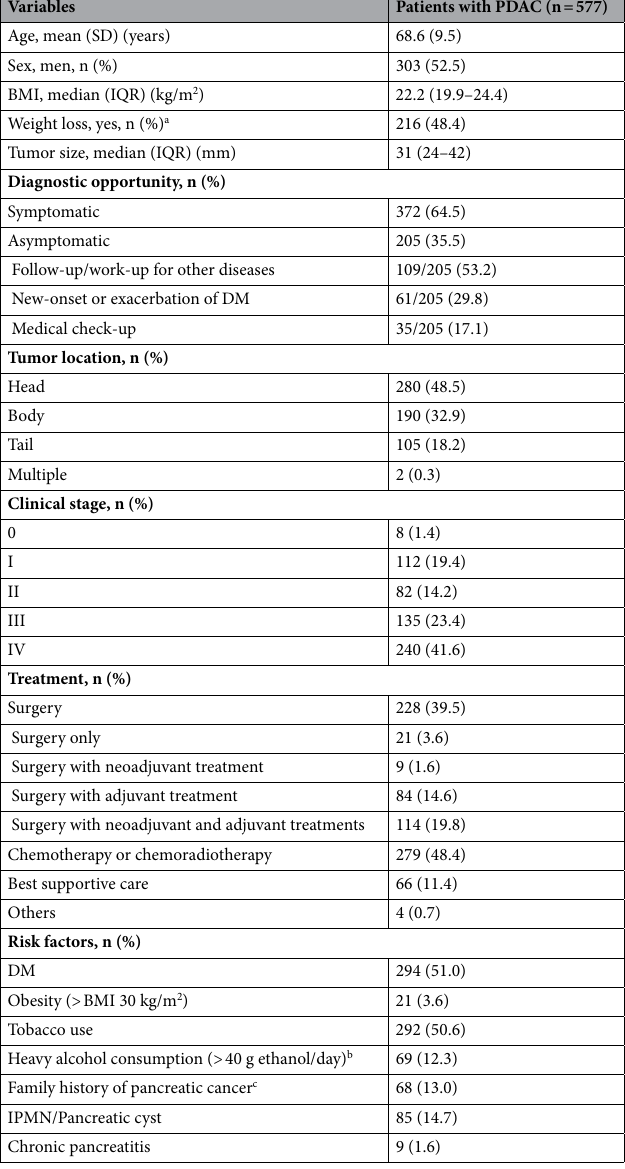
mucinous neoplasm. a Data from 446 patients. b Data from 561 patients. c Data from 522